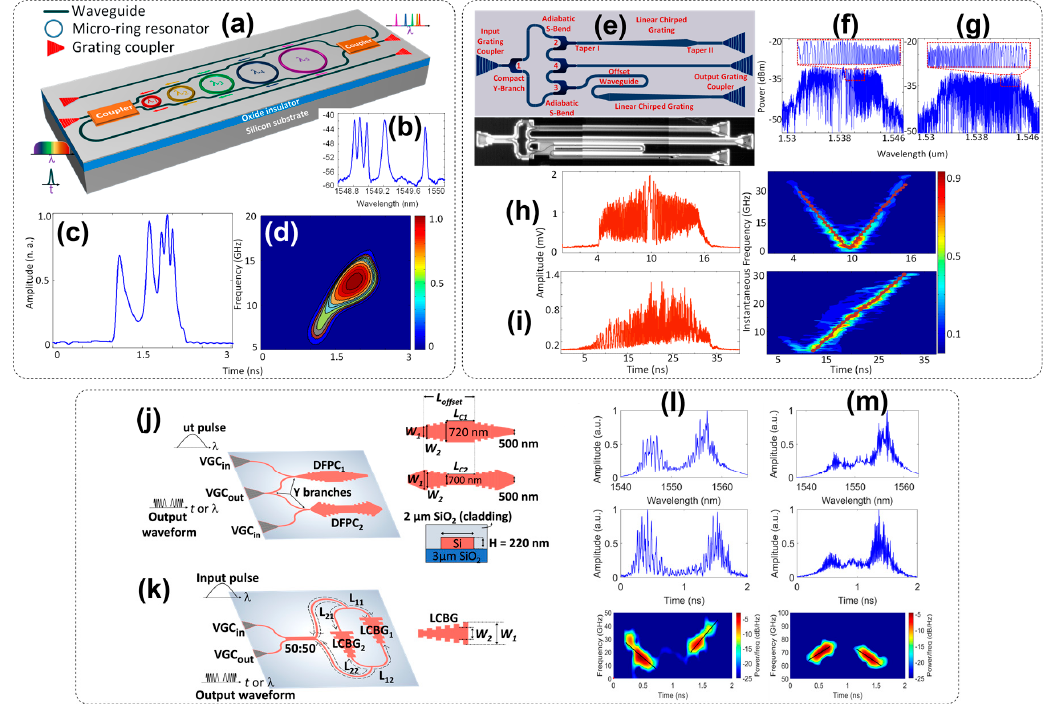
Figure 23. Recently implemented on-silicon-chip spectral shapers. ( a – d ) Spectral shaper consisting of five MRRs reported in [22,140]: ( a ) perspective view of the proposed spectral shaper; ( b ) measured spectral response of the spectral shaper; ( c ) generated linearly chirped microwave waveforms (LCMW) and ( d ) its spectrogram. Courtesy of and adapted from Jianping Yao [22,140]. ( e – i ) Spectral shaper incorporating two linearly chirped Bragg gratings (LCBGs) proposed in [22,137]: ( e ) Schematic layout and image of the fabricated on-chip spectral shaper; ( f , g ) Measured spectral response of the spectral shaper when the offset waveguide length is equal to ( f ) zero, and ( g ) the length of the LCBG; ( h , i ) Experimental results of on-chip spectral shaper corresponding to ( f , g ), respectively. Courtesy of and adapted from Jianping Yao [22,137]. ( j – m ) Spectral shaper of generation of multiple chirped RF waveforms reported in [138]: ( j , k ) proposed spectral shapers based on ( j ) parallel distributed Fabry-P é rot cavities (DFPCs) and ( k ) an arrayed waveguide Sagnac interferometer (AWGSI) incorporating LCBGs; ( l , m ) Experimental results for simultaneous generation of two chirped RF waveforms using the spectral shapers based on ( l ) DFPCs and ( m ) AWGSI incorporating